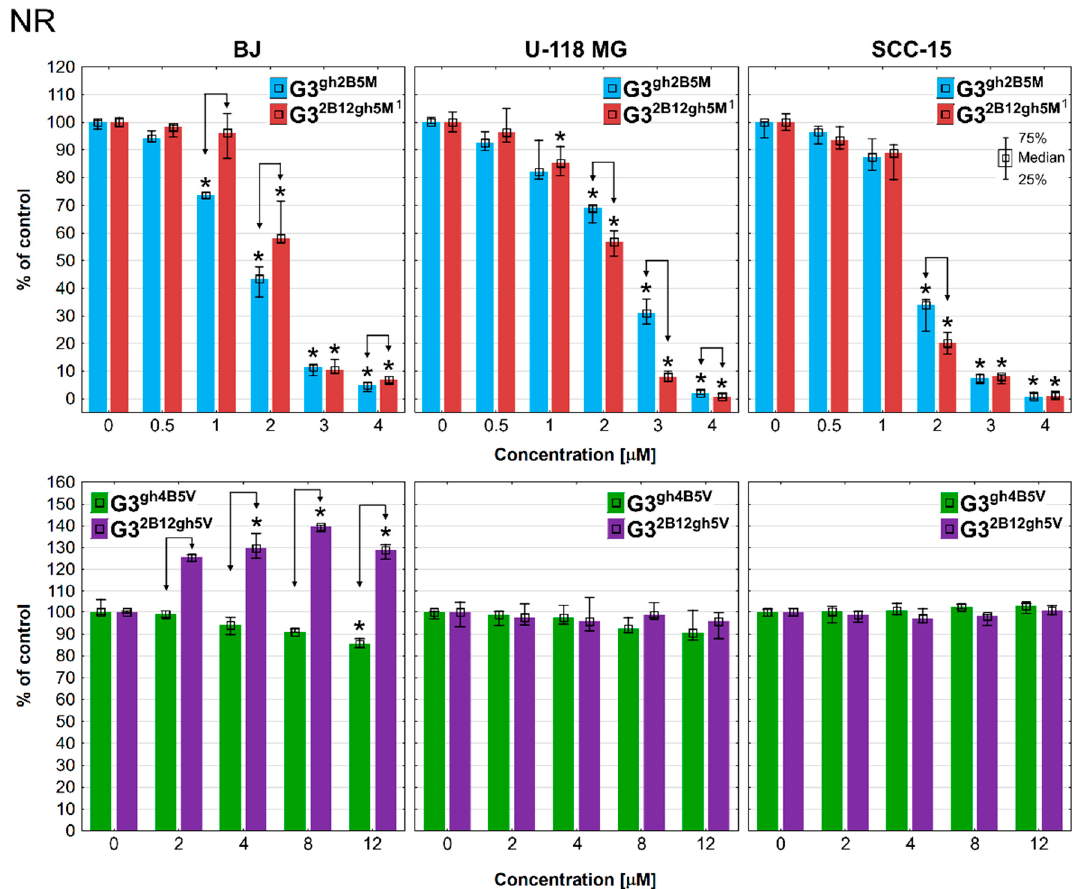
Figure 3. Cytotoxic effect of dendrimers conjugated via ester or amide bond with α M ( G3 gh2B5M and G3 2B12gh5M ) and V ( G3 gh4B5V and G3 2B12gh5V ) after 48 h of incubation with normal fibroblasts (BJ), glioblastoma cells (U-118 MG), and squamous carcinoma cells (SCC-15), estimated with the NR assay. Cell viability (expressed as percent of the non-treated control) medians are plotted. The whiskers are lower (25%) and upper (75%) quartile ranges. * p ≤ 0.05; Kruskal-Wallis test (against non-treated control), ↕ p ≤ 0.05; Mann-Whitney U test (ester against amide-attached drug-conjugate). 1 Data for G3 2B12gh5M were reproduced from [29].